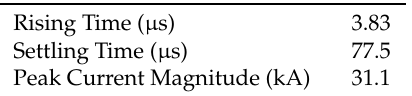
Table 1. Lightning discharge characteristics.